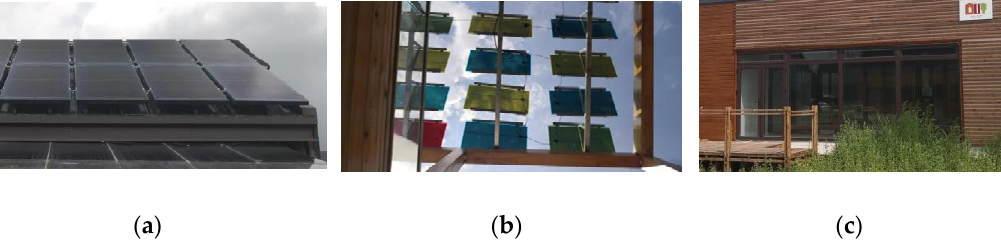
Figure 7. Photovoltaic modules: ( a ) SRF photovoltaic panel; ( b ) HIT photovoltaic film; and ( c ) DUT photo- voltaic glass.